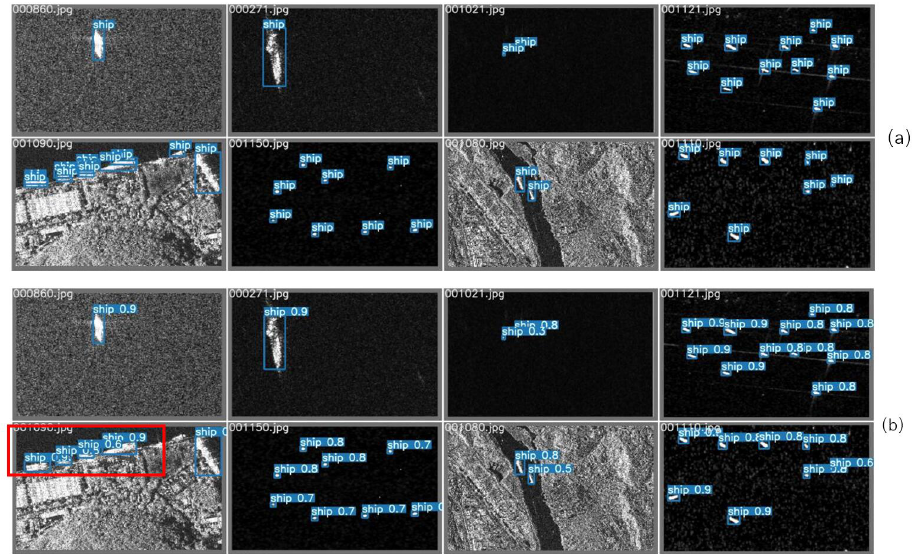
Figure 12. The visual analysis of the detection result of the proposed FASC-Net. ( a ) SAR images and labels. ( b ) The detection